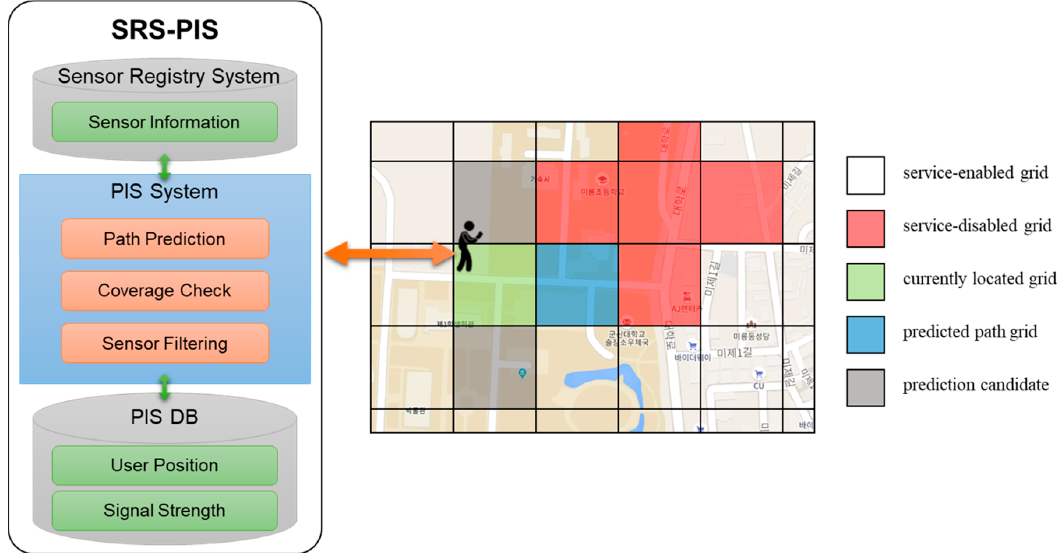
Figure 3. Concept of the SRS-based predictive information service (SRS-PIS) using a